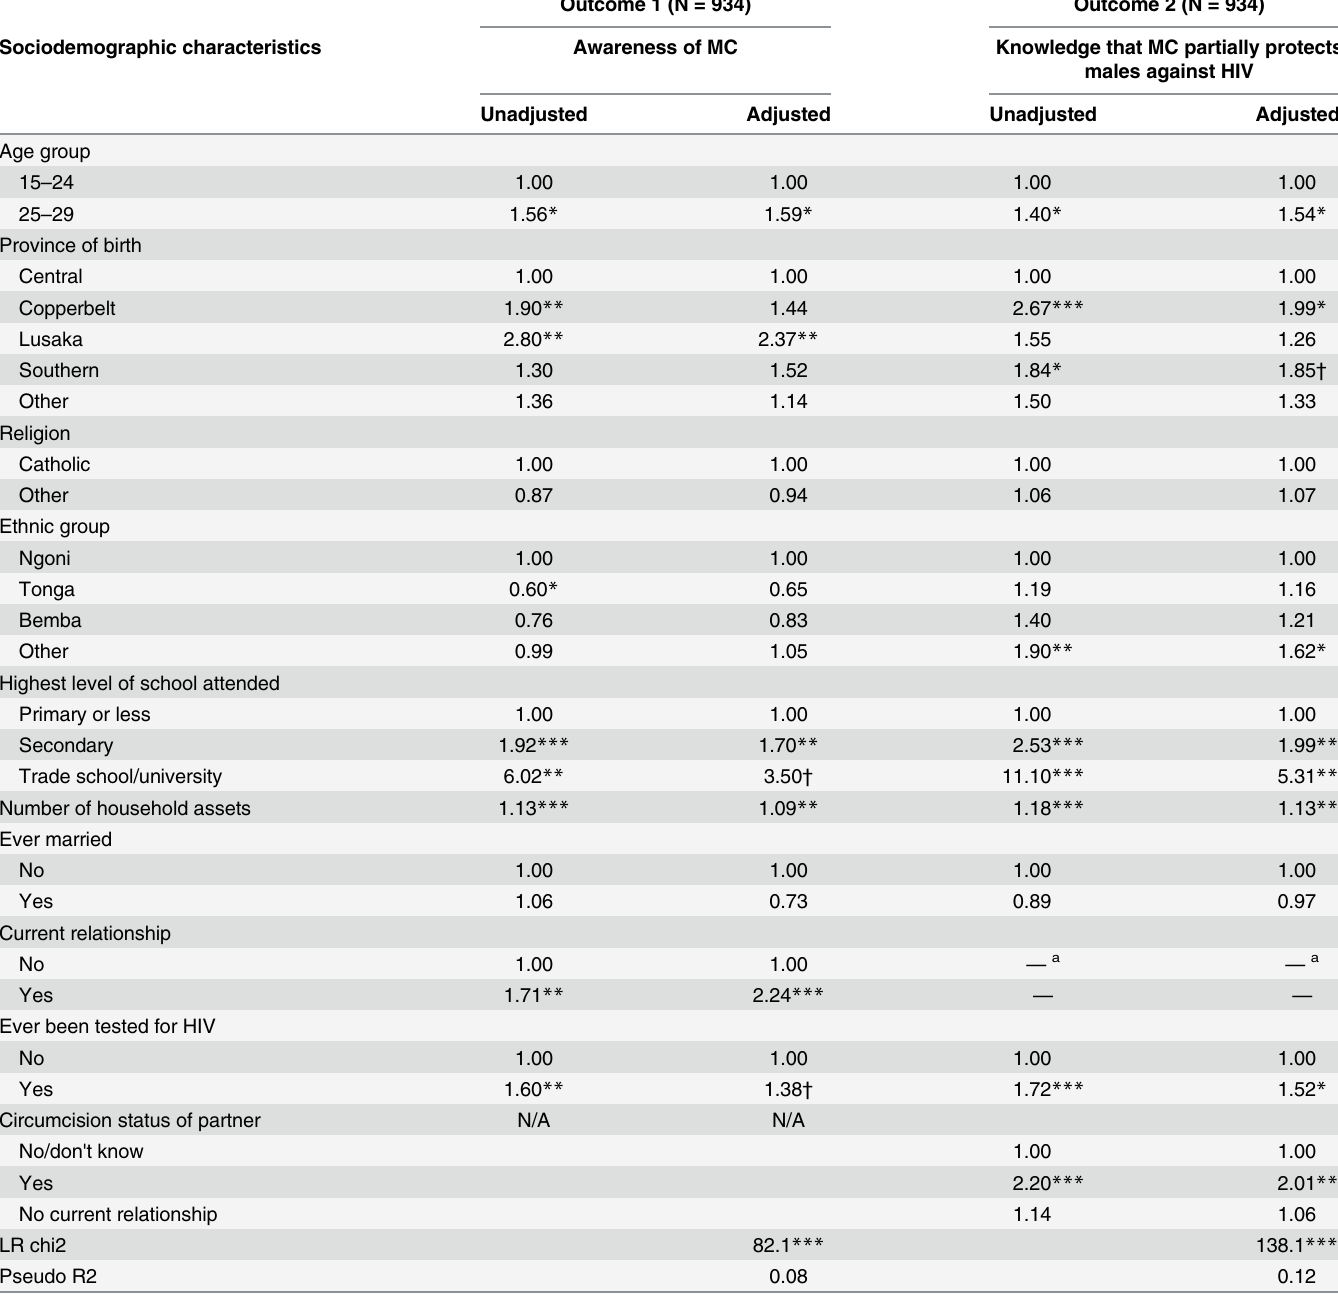
Table 3. Odds ratios from unadjusted and adjusted logistic regression models identifying associations between sociodemographic characteris- tics and 1) awareness of male circumcision (MC) and 2) knowledge that MC partially protects males against